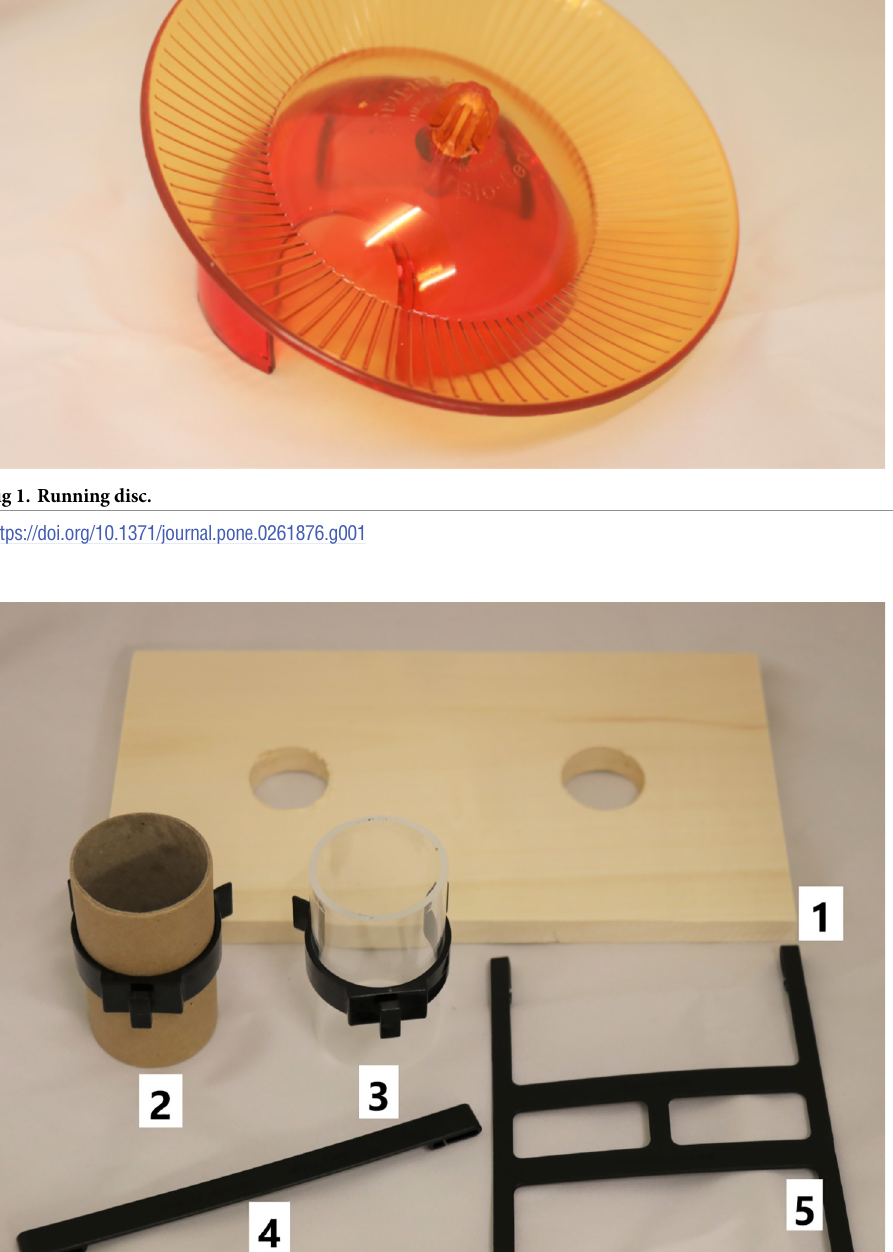
PLOS ONE | https://doi.org/10.1371/journal.pone.0261876 December23,